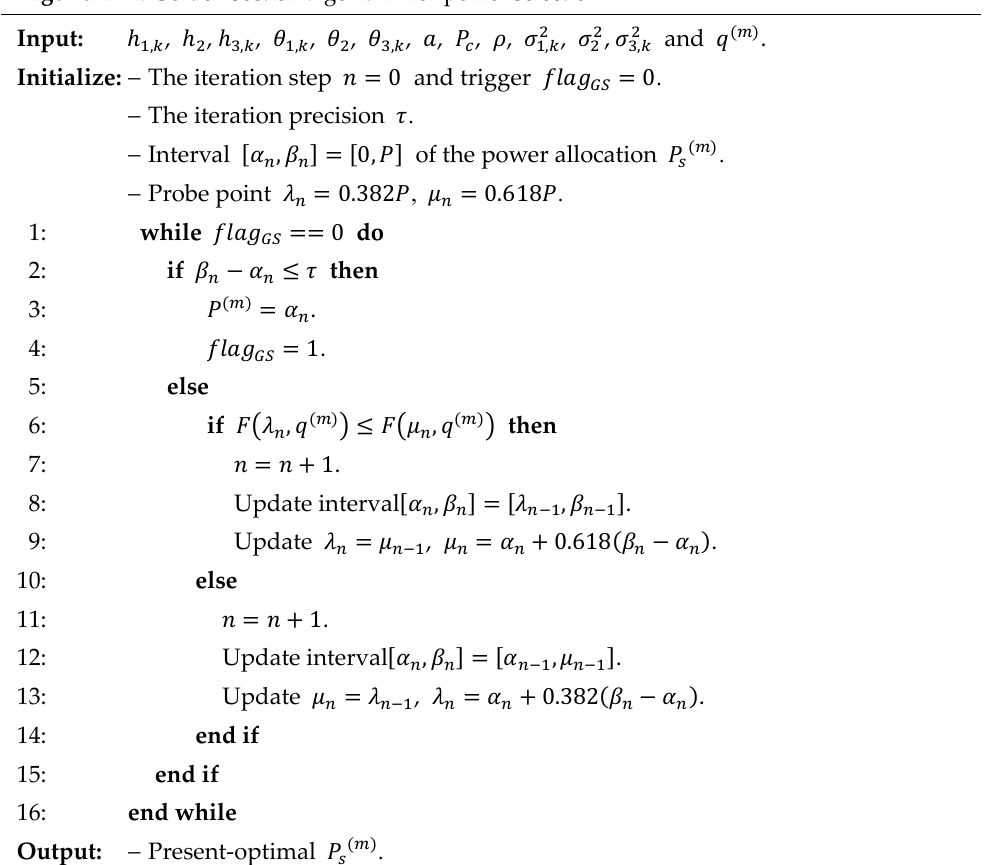
Algorithm 2. Golden section algorithm for power selection. Algorithm 2 Golden section algorithm for power